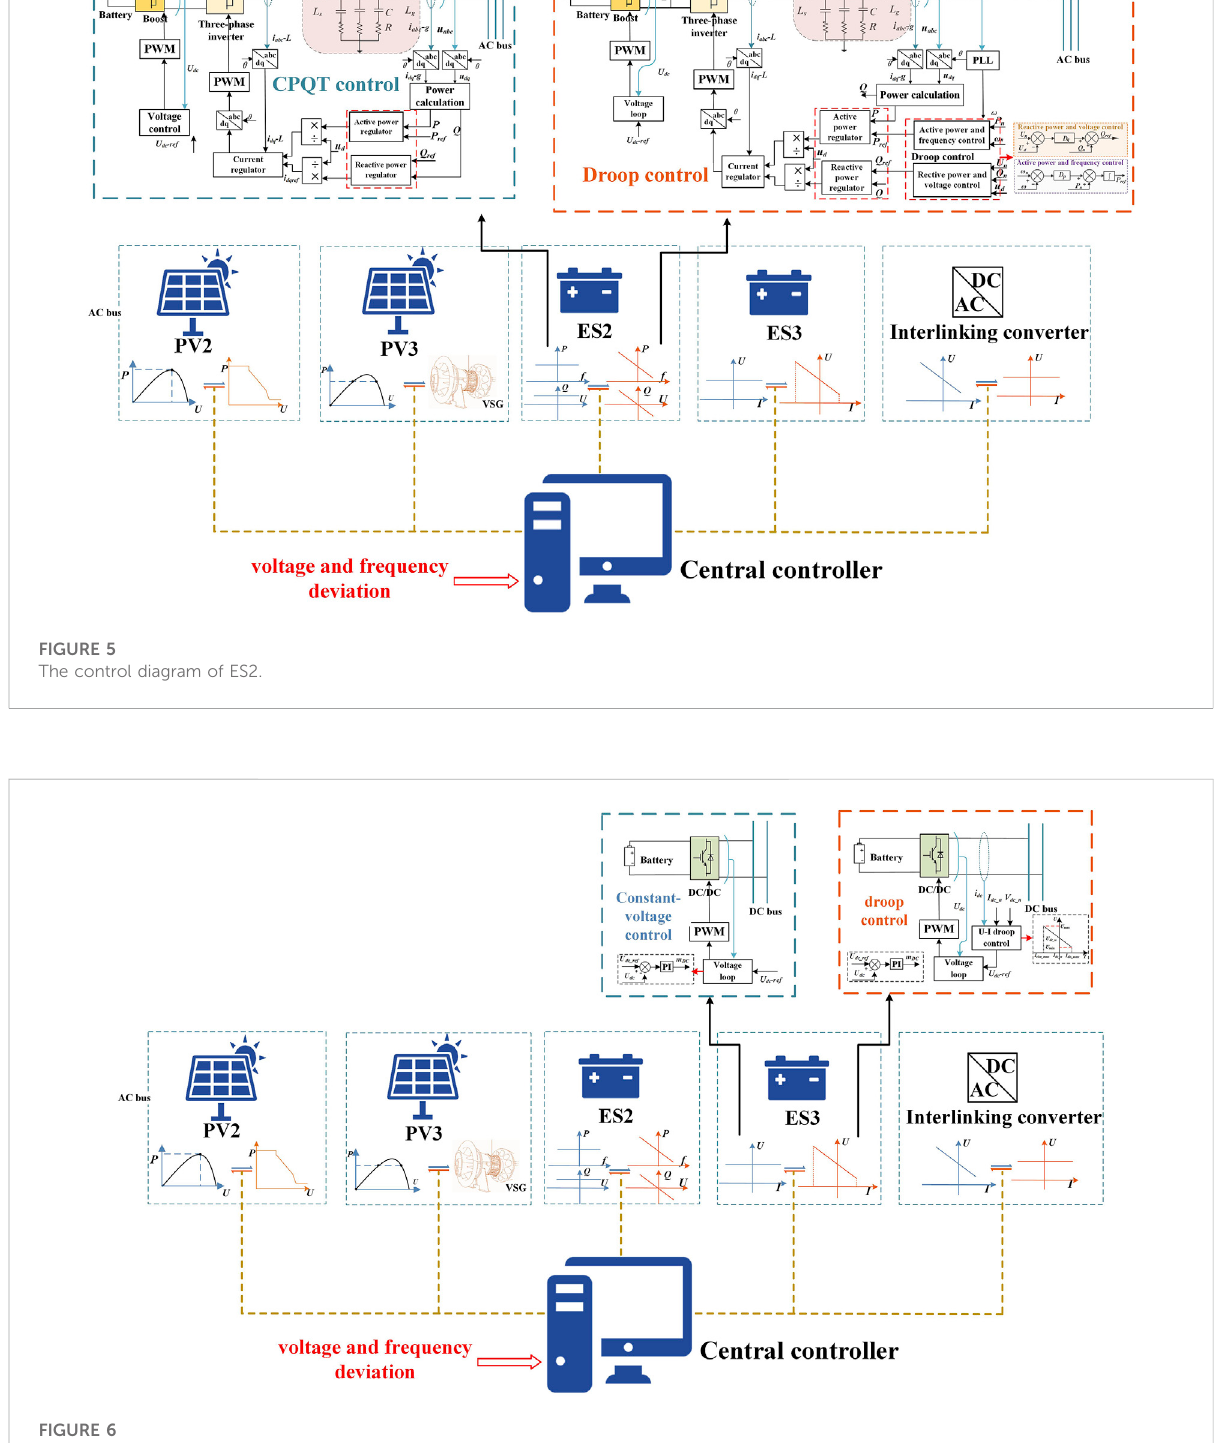
FIGURE 6 The control diagram of